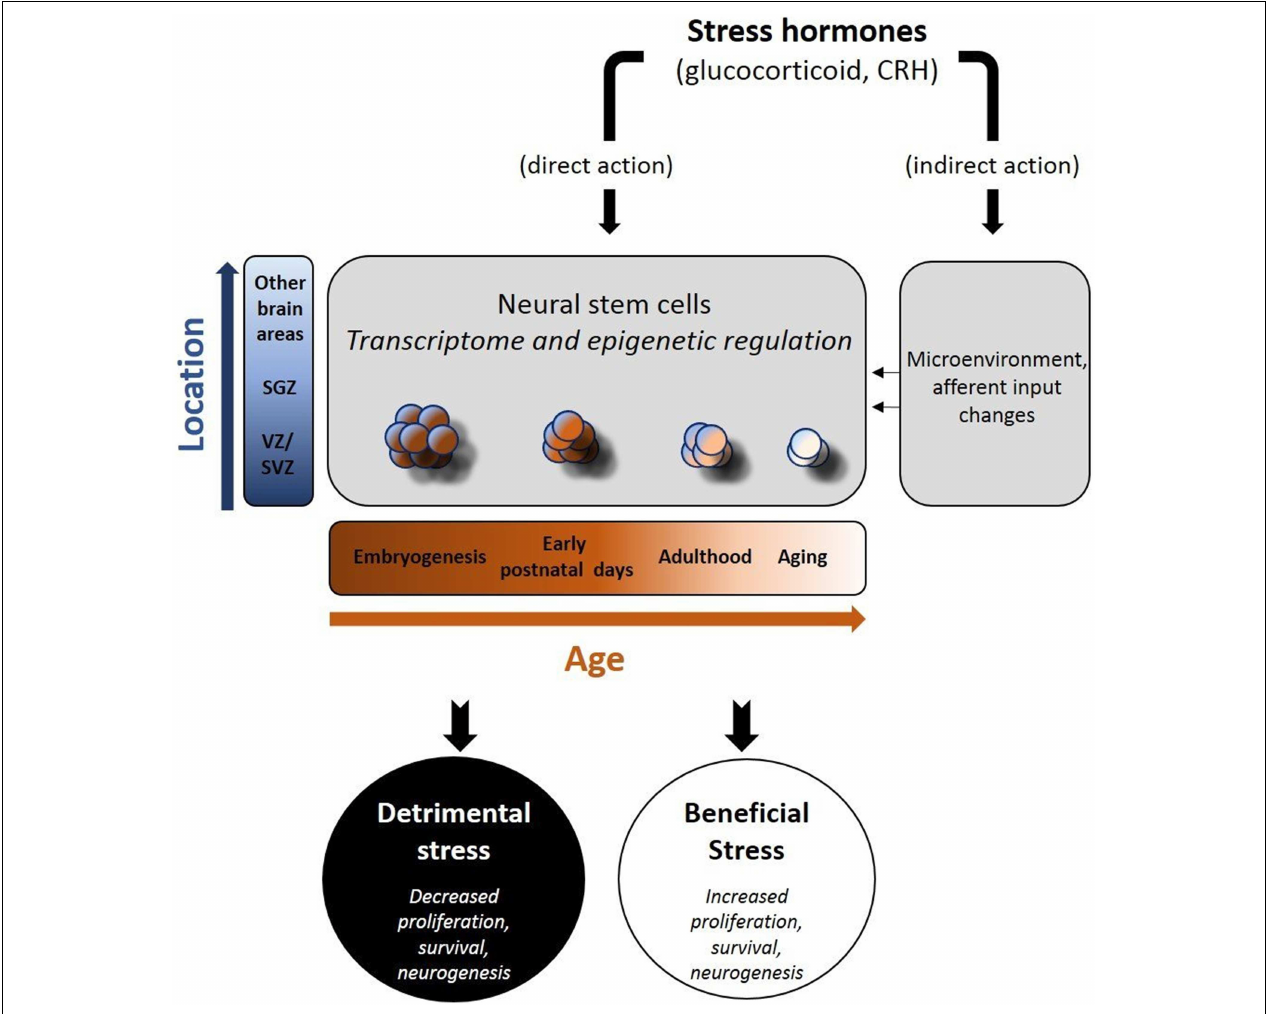
manner), NSCs react either due to direct exposure to stress hormones (direct action) and/or following the stress hormone-induced changes in their “niches(s)” (indirect action). The nature of the stressor, the location of NSCs and the time in the development are major determinants of the short- and long-term effects in brain